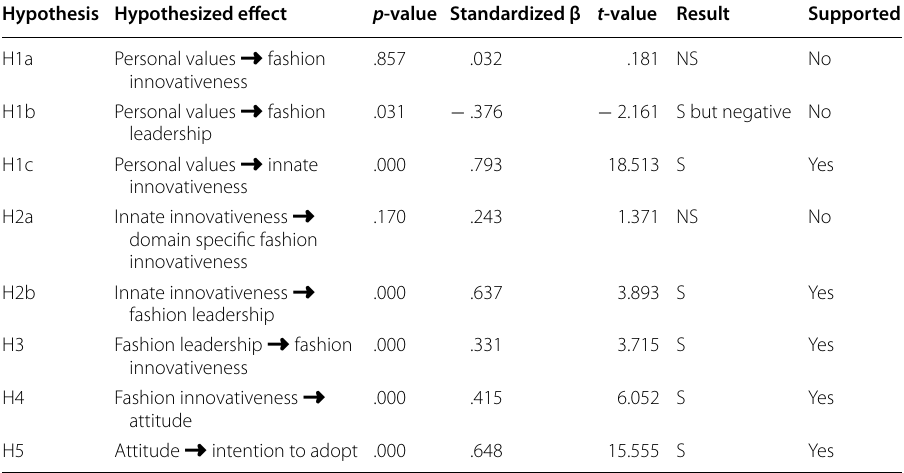
S significant, NS non-significant